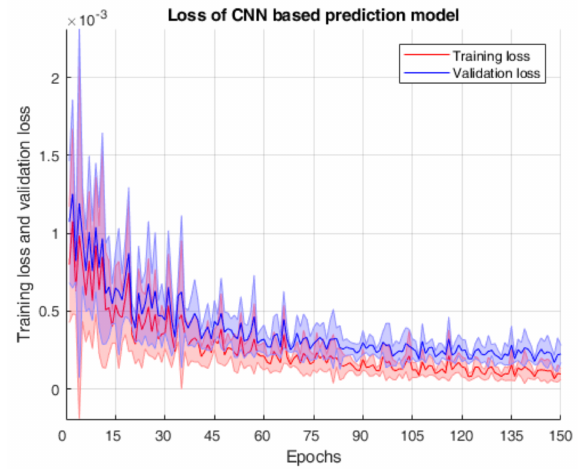
Figure 6. Loss curves of the CNN-based prediction model over 5 trials. The solid lines and the shaded areas represent the mean and the standard deviation over 5 trials, respectively.